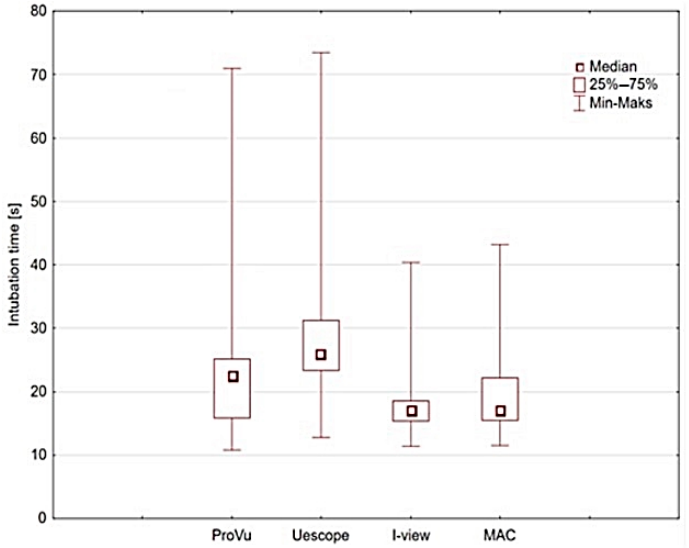
Figure 4. Median time to successful intubation by different types of video laryngoscopes and classic Macintosh laryngoscope (MAC).